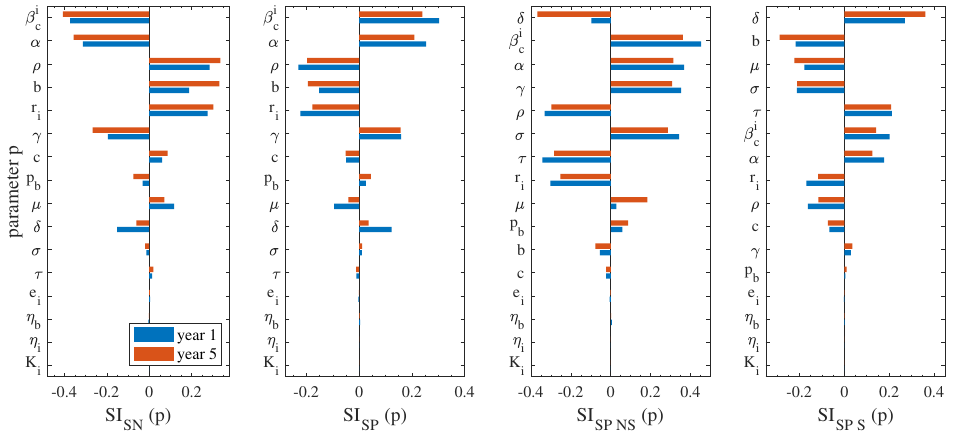
Figure 6. Visualised sensitivities SI of the model outputs for each parameter p calculated by Equation (8) after one and five years (blue and red bars, respectively), for the continuous housing case. The model outputs are the prevalences of seronegative, seropositive, seropositive non-shedding and seropositive shedding cattle and the related sensitivities SI SN , SI SP , SI SP NS and SI SP S are shown from the left panel to right one. The indices SI are sorted in descending order on the basis of the 5-year